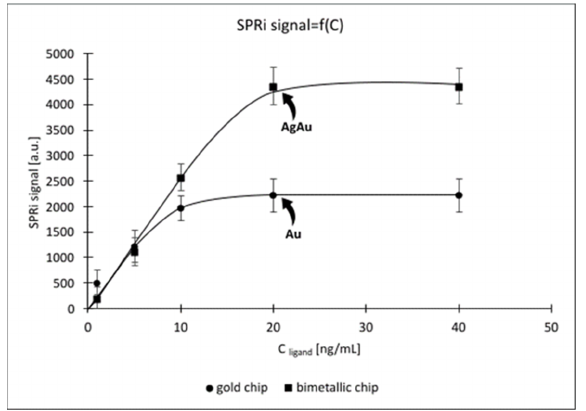
Figure 3. Saturation of the sensor surface with ligand. VEGFR-2 concentration was 5 ng/mL, pH = 7.40.